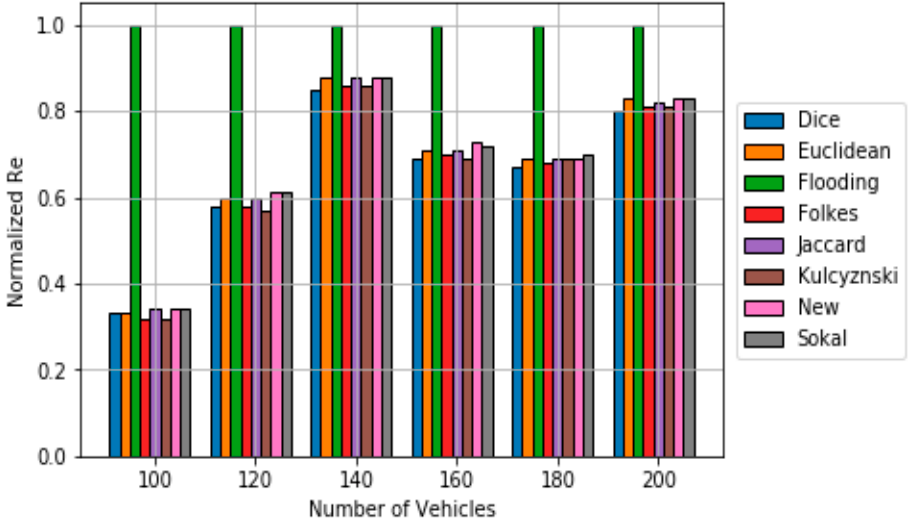
Figure 10. Comparison of Reachability results for the irresponsible scheme based on the different dissimilarity metric.